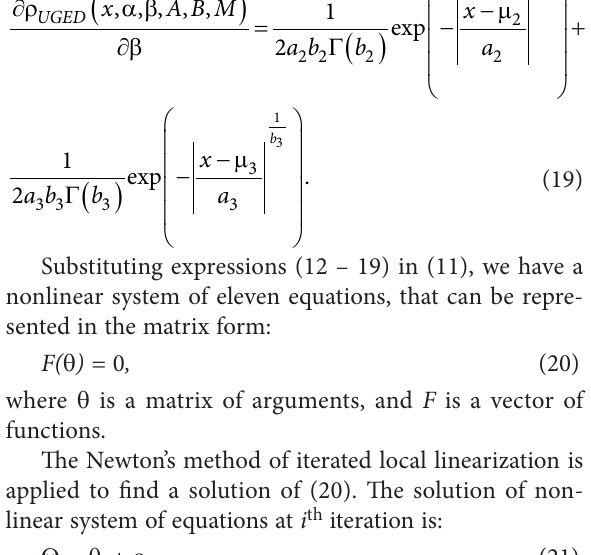
Table 1. The search intervals and starting point for evaluated parameters